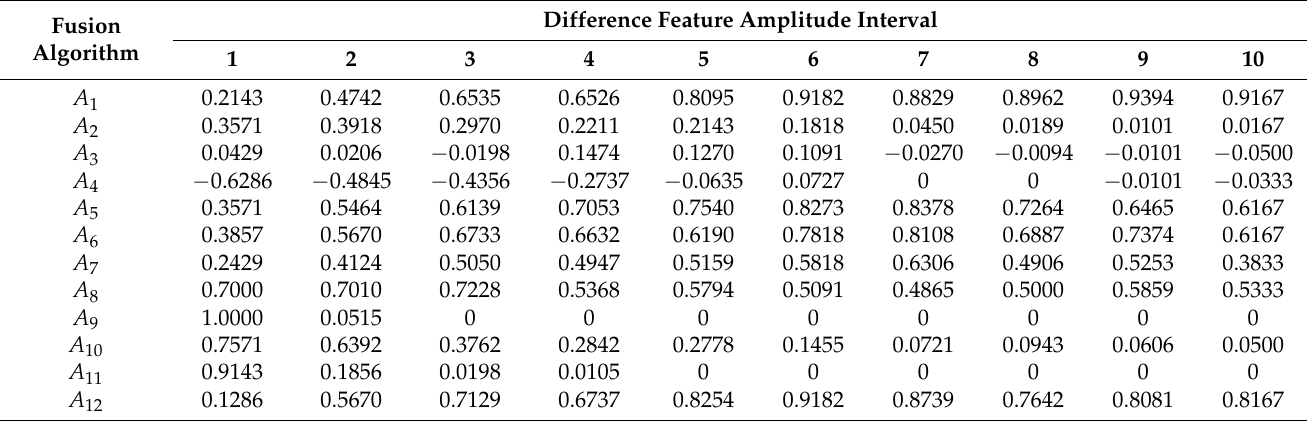
Table 2. Score results in the range of the 1st of difference feature amplitude interval through the 10th interval. Fusion